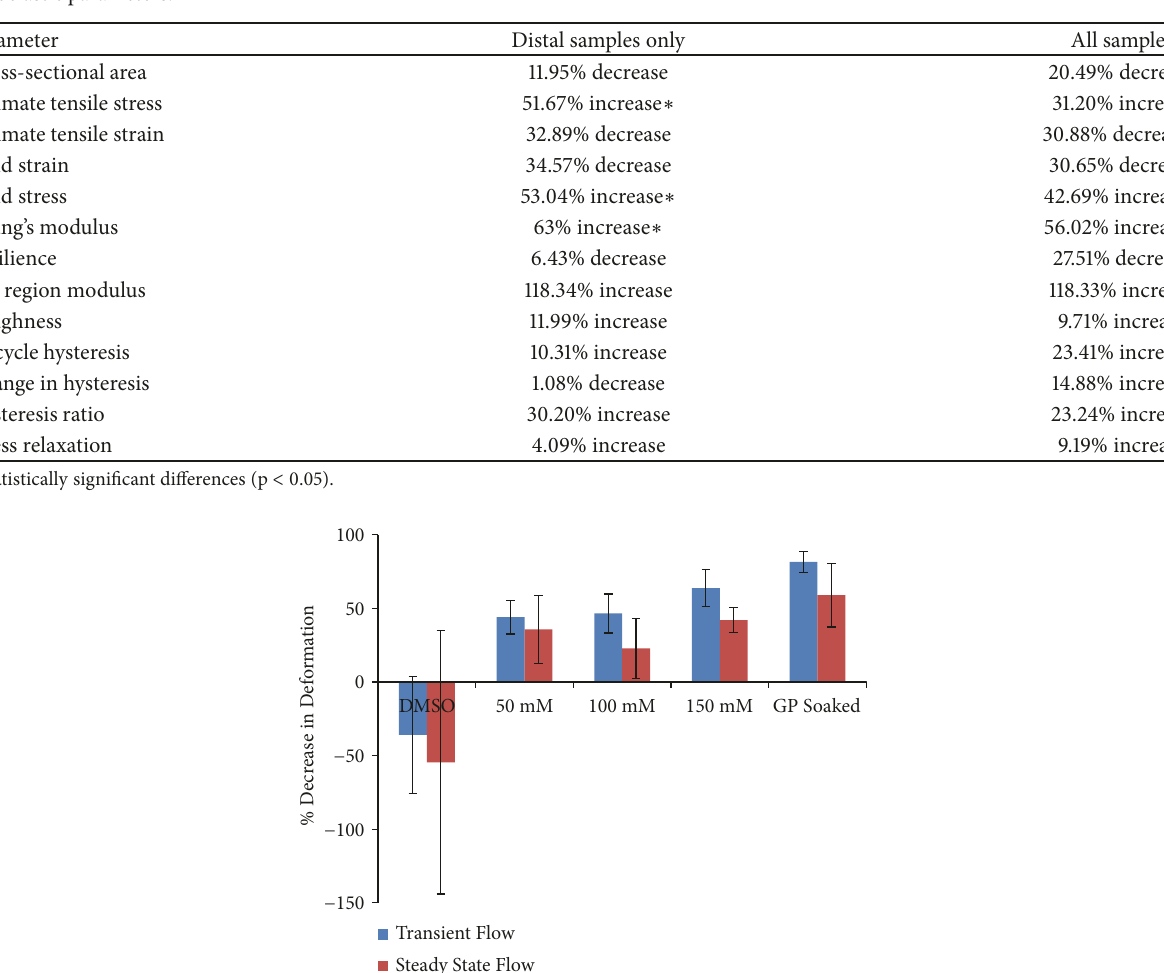
Table 1: Mean differences between genipin-treated specimens (50mM) compared to buffer-only treatment for each of elastic-plastic and viscoelastic parameters.